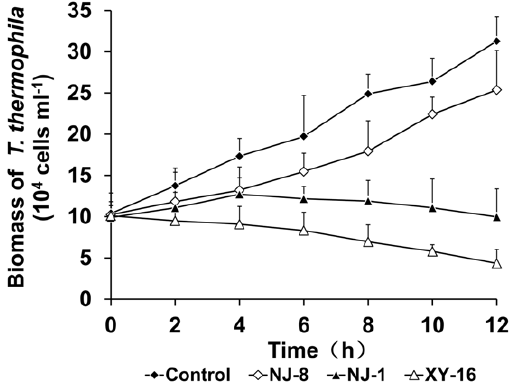
Figure 5. Growth of T.thermophila co-cultivated with Aeromonas isolates of different virulence. Growth of T. thermophila co-cultured with A. hydrophila XY-16, A. hydrophila NJ-1 and A. media NJ-8 was measured for 12 h after initiating the co-culture. The control group was T. thermophila grown alone in sterile SPP medium. Data are expressed as the mean + SD of six measurements per time